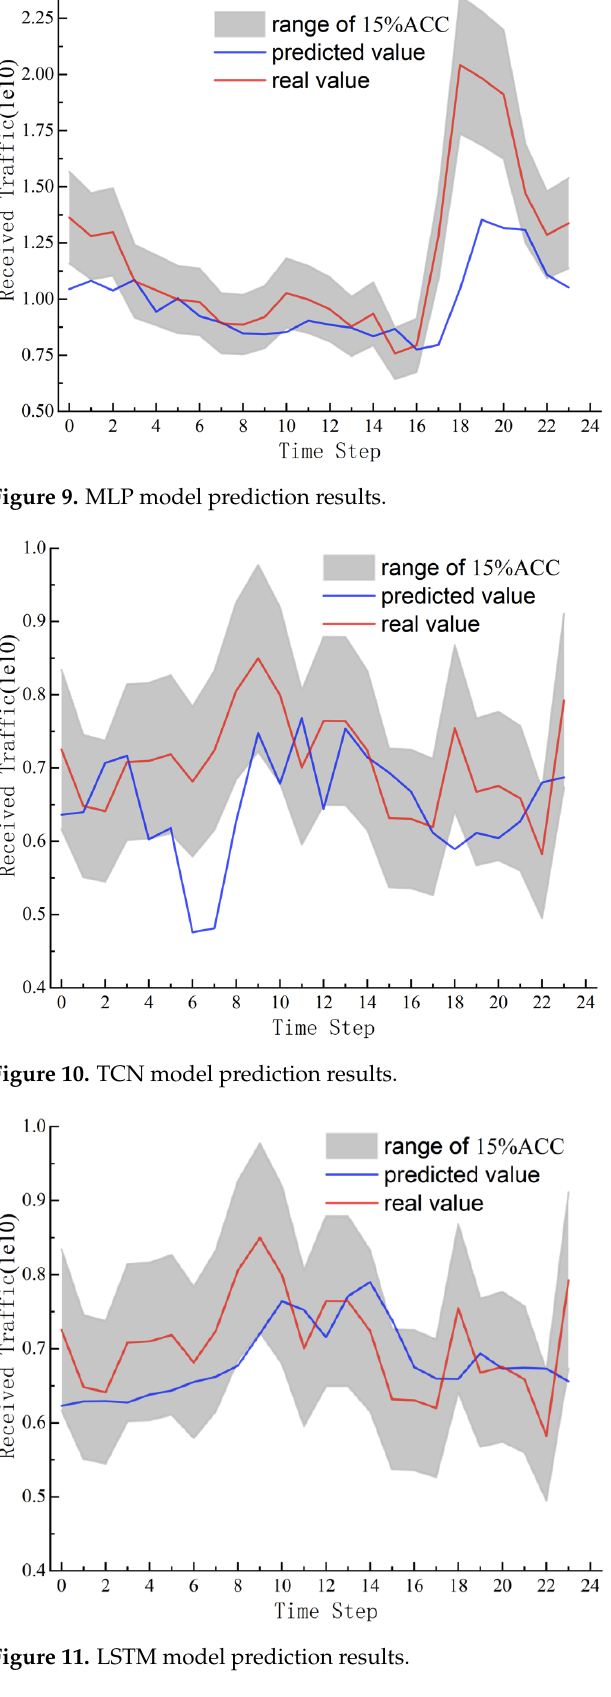
Figure 11. LSTM model prediction results.